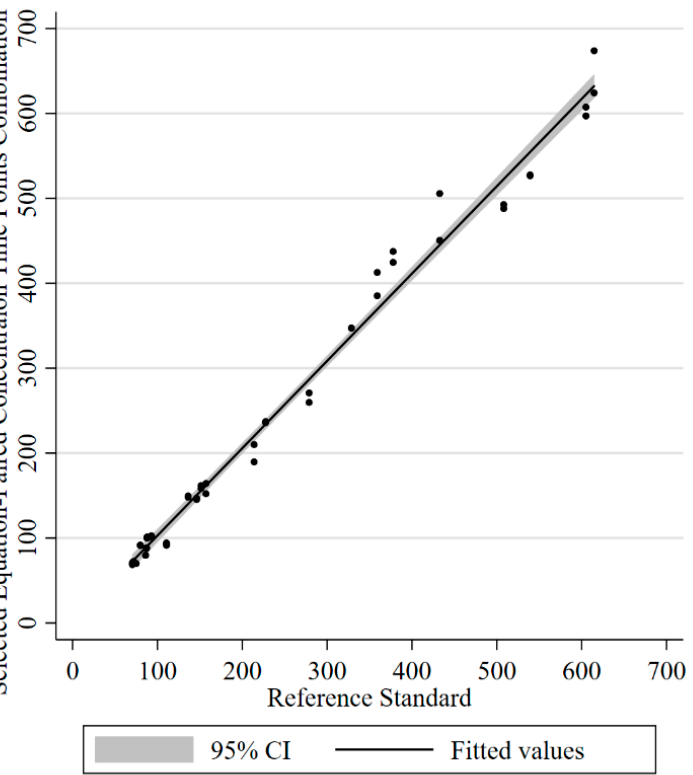
Figure 3. The regression line between the reference standard AUC f and pooled selected equation- paired concentration time point combinations. The regression equation was y = 0.15 + 1.03x (R 2 = 0.988, p < 0.001). Pearson’s correlation coefficient between the two methods was r = 0.994 ( p < 0.001). Abbreviations: AUC f , full area under the plasma concentration-time curve.